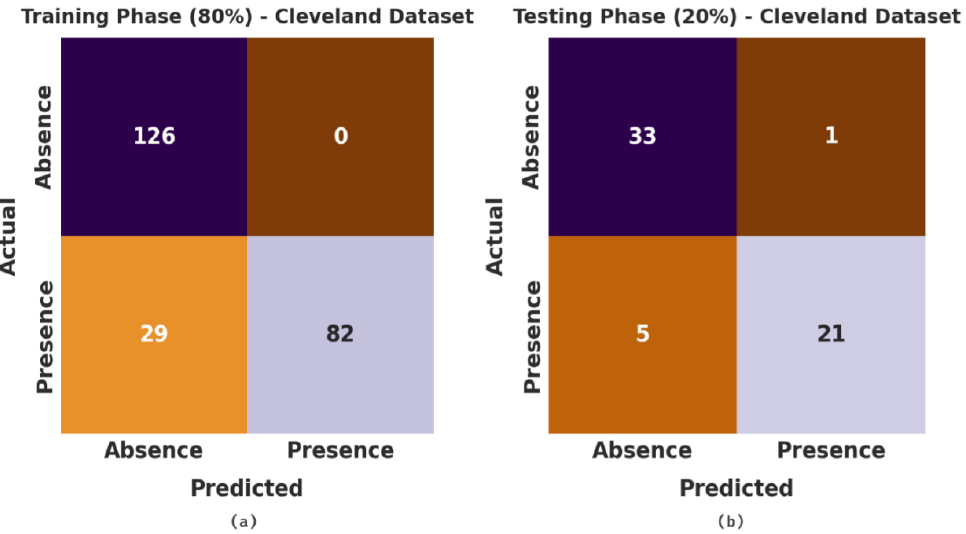
Figure 4. Confusion matrices of MLMDMC-ED method on Cleveland dataset ( a , b ) TR and TS data- base of 80:20 and ( c , d ) TR and TS database of 70:30. Table 2 and Figure 5 portray the detection results obtained by the proposed MLMDMC-ED method on the Cleveland dataset. On 80% of the TR database, the pro- posed model gained the average 𝑎𝑐𝑐𝑢 𝑏𝑎𝑙 , 𝑝𝑟𝑒𝑐 𝑛 , 𝑟𝑒𝑐𝑎 𝑙 , 𝐹 𝑠𝑐𝑜𝑟𝑒 , and MCC values of 86.94%, 90.65%, 86.94%, 87.33%, and 77.49%, respectively. Moreover, on 20% of the TS database, the presented model gained the average 𝑎𝑐𝑐𝑢 𝑏𝑎𝑙 , 𝑝𝑟𝑒𝑐 𝑛 , 𝑟𝑒𝑐𝑎 𝑙 , 𝐹 𝑠𝑐𝑜𝑟𝑒 , and MCC values of 88.91%, 91.15%, 88.91%, 89.58%, and 80.03% respectively. Furthermore, on 70% of the TR database, the MLMDMC-ED model attained the average 𝑎𝑐𝑐𝑢 𝑏𝑎𝑙 , 𝑝𝑟𝑒𝑐 𝑛 , 𝑟𝑒𝑐𝑎 𝑙 , 𝐹 𝑠𝑐𝑜𝑟𝑒 , and MCC values of 90.51%, 91.28%, 90.51%, 90.72%, and 81.78% correspond- ingly.